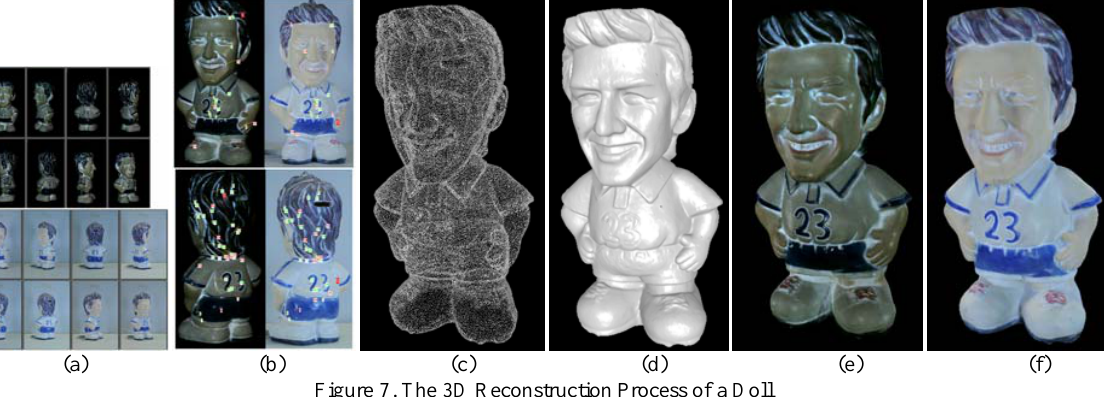
Figure 7. The 3D Reconstruction Process of a Doll